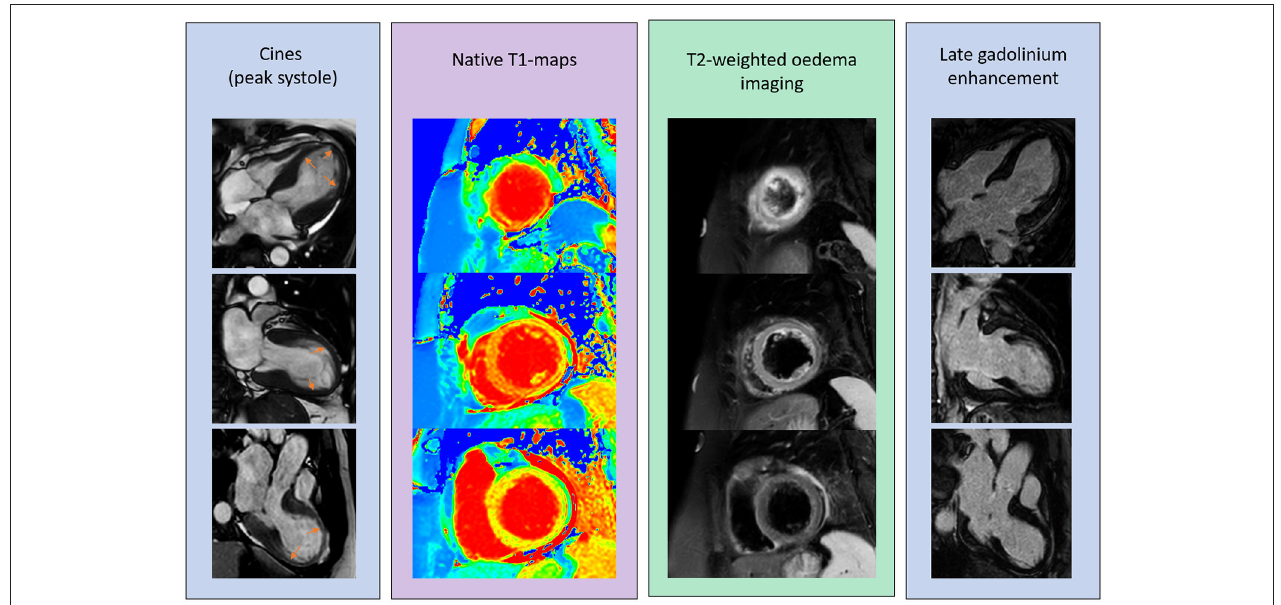
FIGURE 3 | Multi-parametric tissue characterisation of the myocardium to aid diagnosis. This is a case of a 57 year old lady who presents with acute chest pain, ST elevation, and raised troponin biomarkers. Her coronary angiogram was normal. An acute CMR revealed apical ballooning demonstrated in the 4CH view by orange arrows, rise in myocardial oedema on T2-weigthed imaging and confirmed on quantitative native T1-maps (white arrows). There was no evidence of scar on late gadolinium enhancement imaging and overall the extracellular volume was relatively not high as T1-values. This is suggestive of more intra-cellular swelling than extracellular expansion in an acute setting.